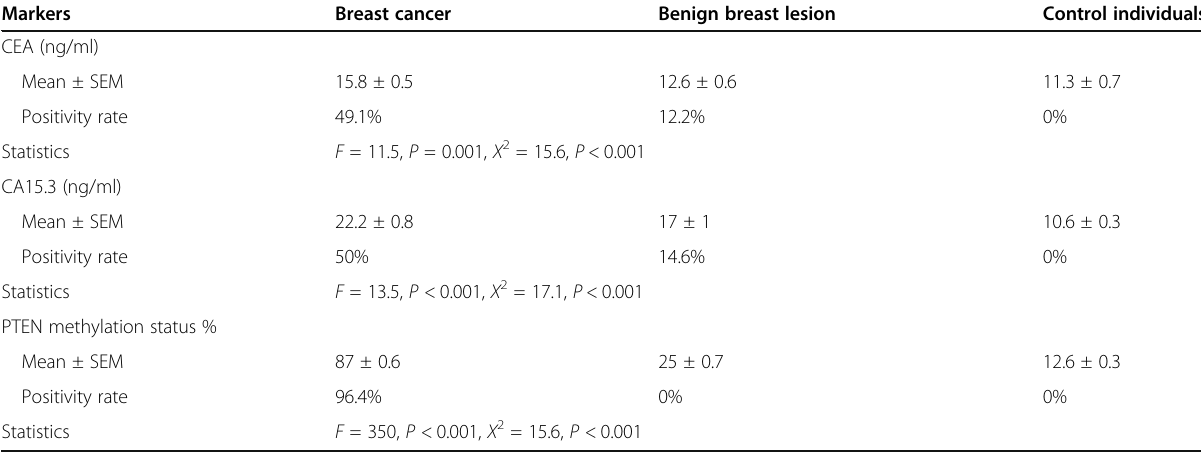
Table 2 Distribution of mean levels and positivity rates for tumor markers and PTEN methylation status